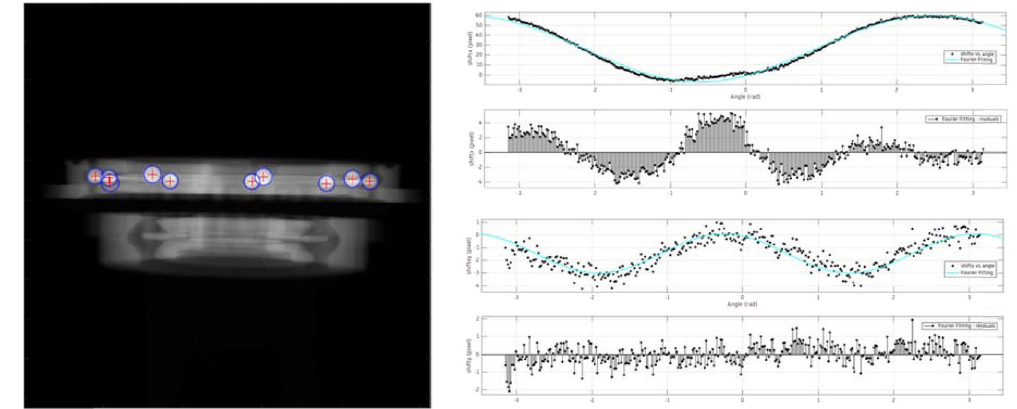
Figure 5. The drilling holes in the ball bearing are used to calculate the motion. The centroid positions of these features are tracked for several rotation angles of the sample. During this procedure, the positions of features are recorded even though they are not available at every projection angle during data acquisition. Once the procedure is completed, one term Fourier fitting is applied to translate the centroid positions to residual shifts from the ideal position of the center beam.